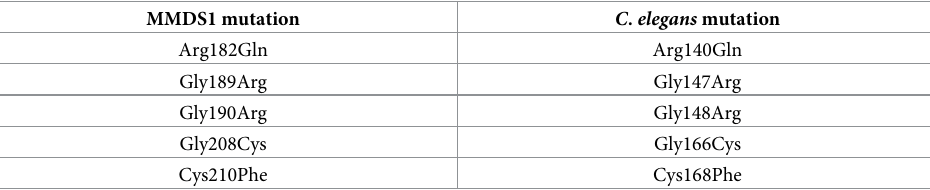
Table 1. Summary of MMDS1 alleles modeled in this